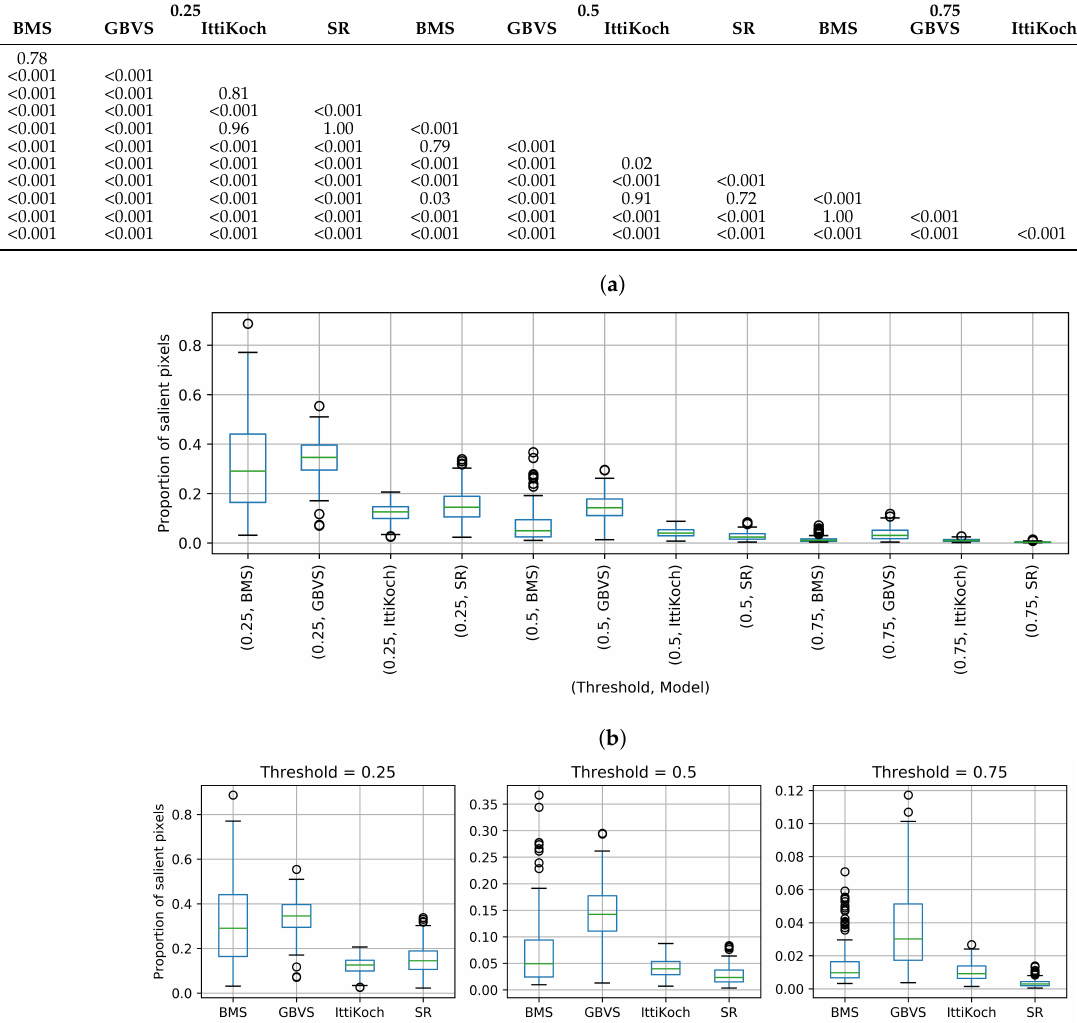
Figure 7. ( a ) Proportion of salient pixels over different saliency thresholds. ( b ) Detailed view over the scale of each